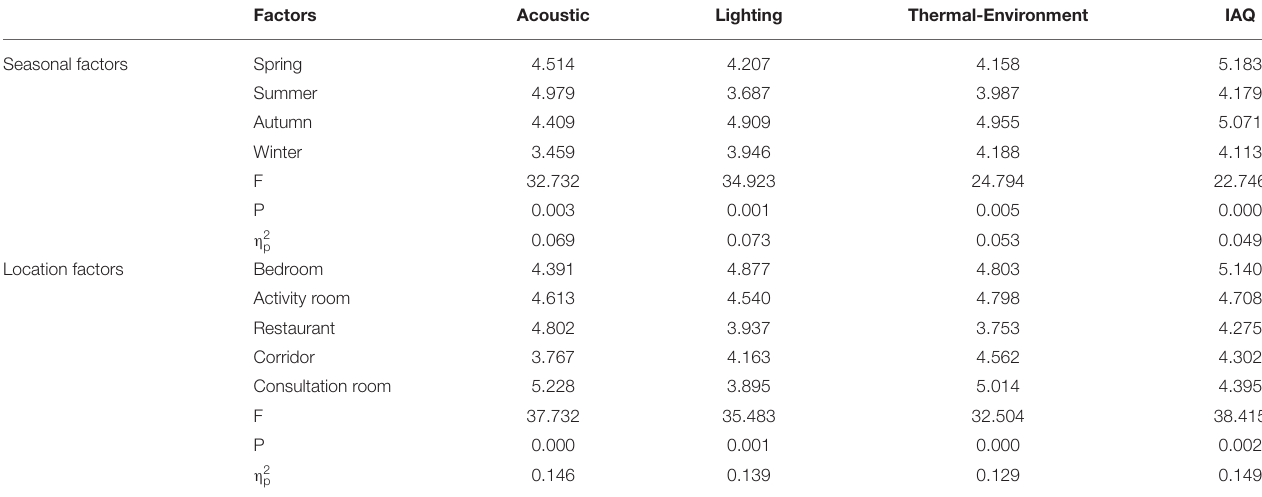
TABLE 5 | Evaluations of IEQ factors based on seasonal differences and location